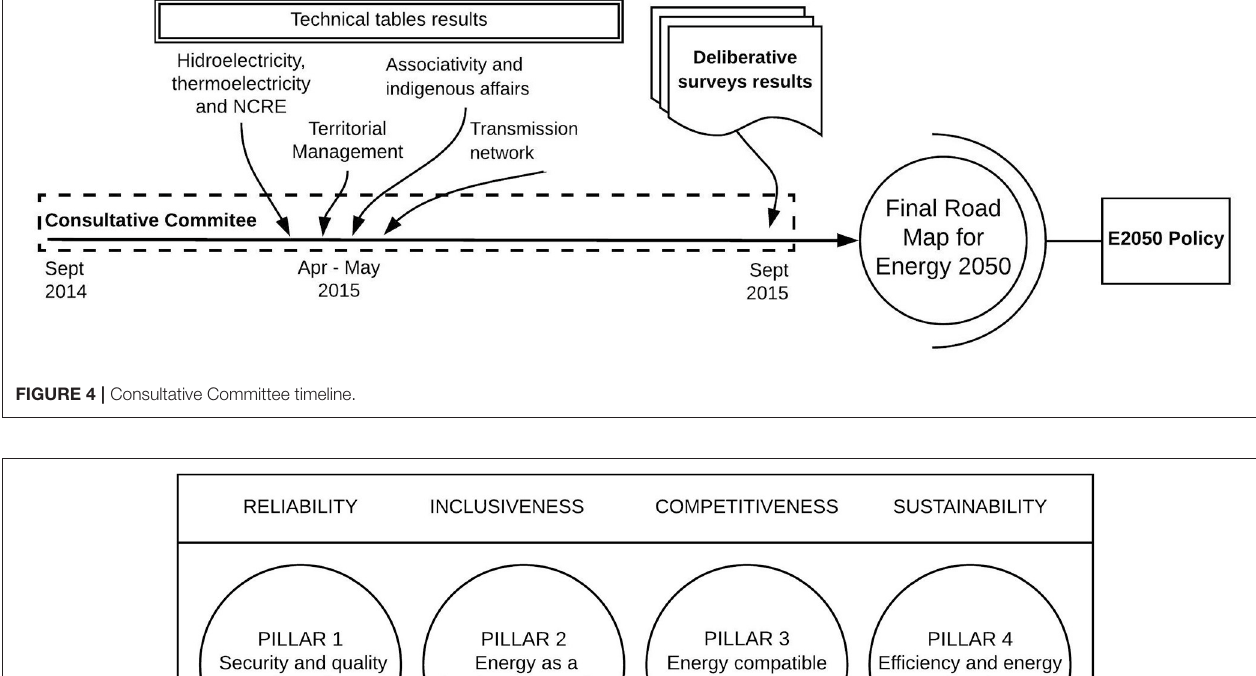
Frontiers in Energy Research |